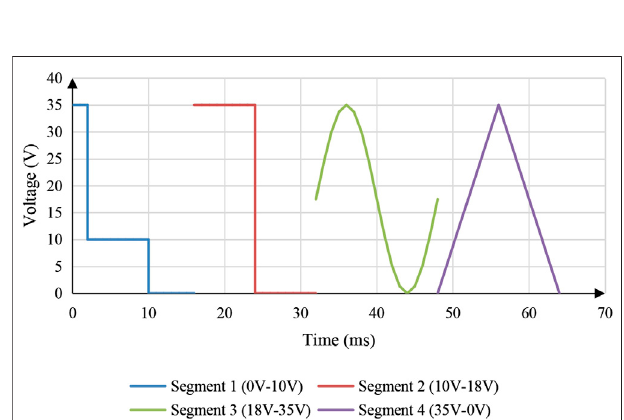
FIGURE 9 | The driving waveform for the fi rst segment of the multi waveform was optimized with an activation voltage. A waveform cycle includes a 2 ms activation phase, an 8 ms driving phase and a 6ms reset phase.